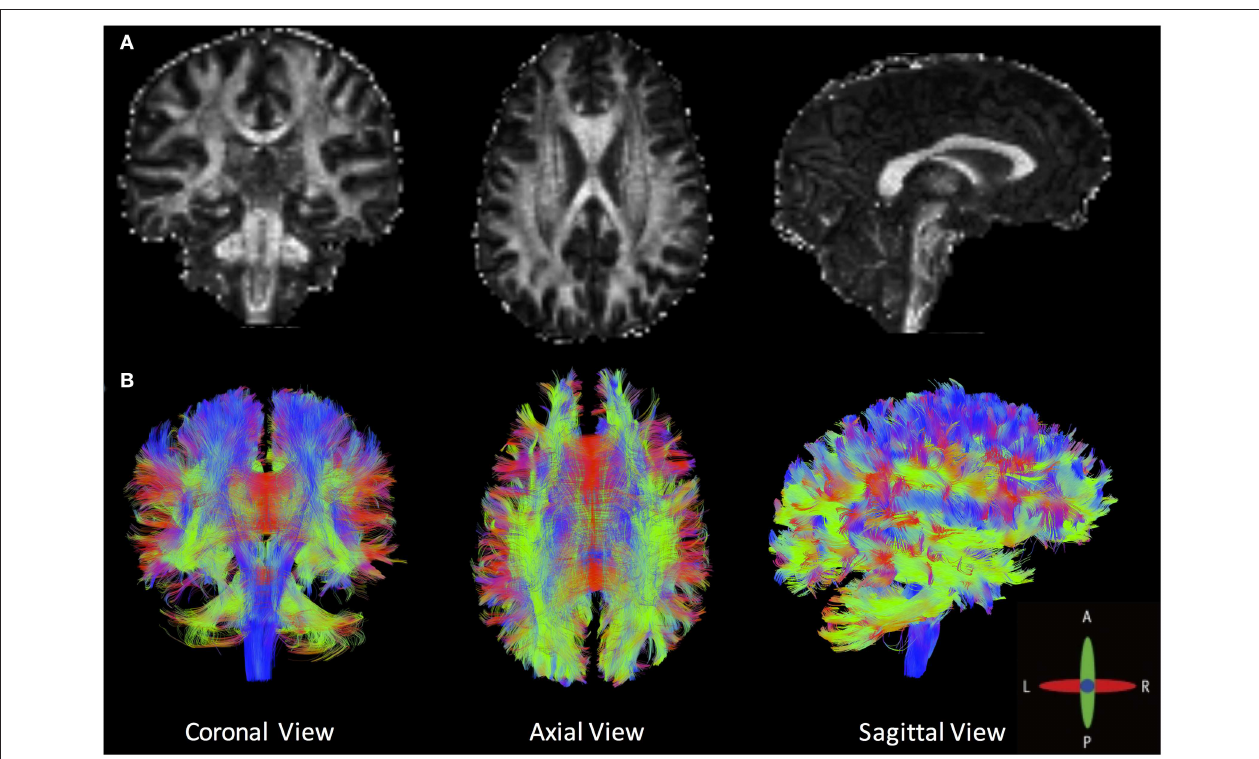
FIGURE 4 | (A) Fractional anisotropy maps and (B) an example of whole-brain deterministic tractography created by DSI Studio in a healthy volunteer (angular threshold: 60 degrees; step size: 1mm; anisotropy threshold: 0.20. Tracks with length shorter than 50 or longer than 300mm were discarded. A total of 500,000 seeds were placed inside the whole